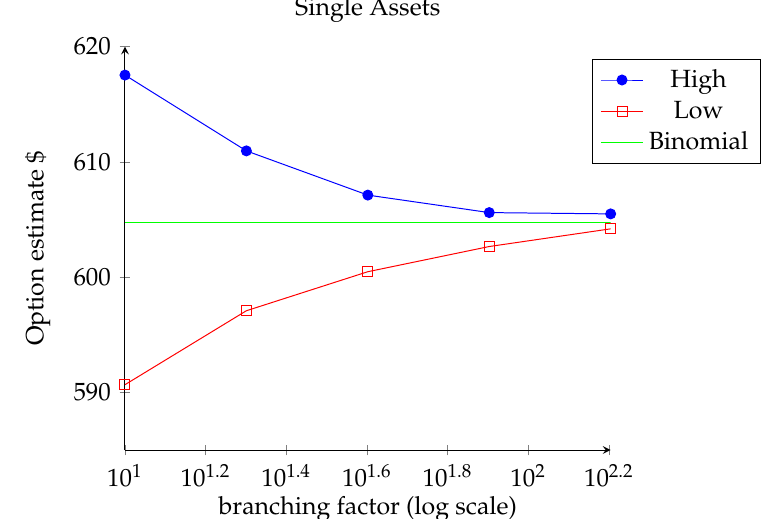
Figure 2. Option value estimates (USD) vs. log branching factor ( b ) with a single underlying